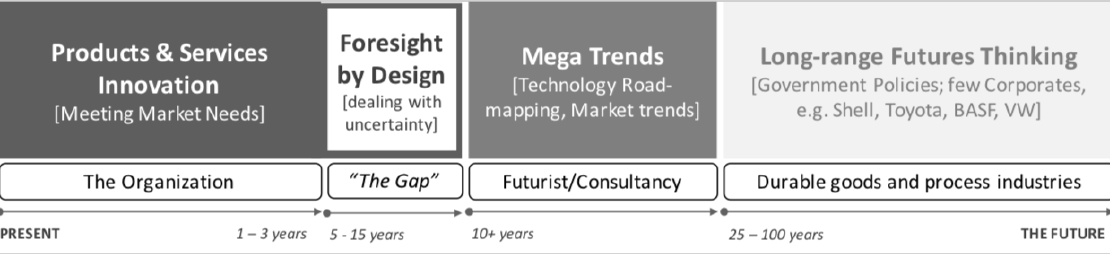
Fig. 1. “Foresight by Design” – addressing the ‘systematic futures thinking’ gap across the medium to longer-term time